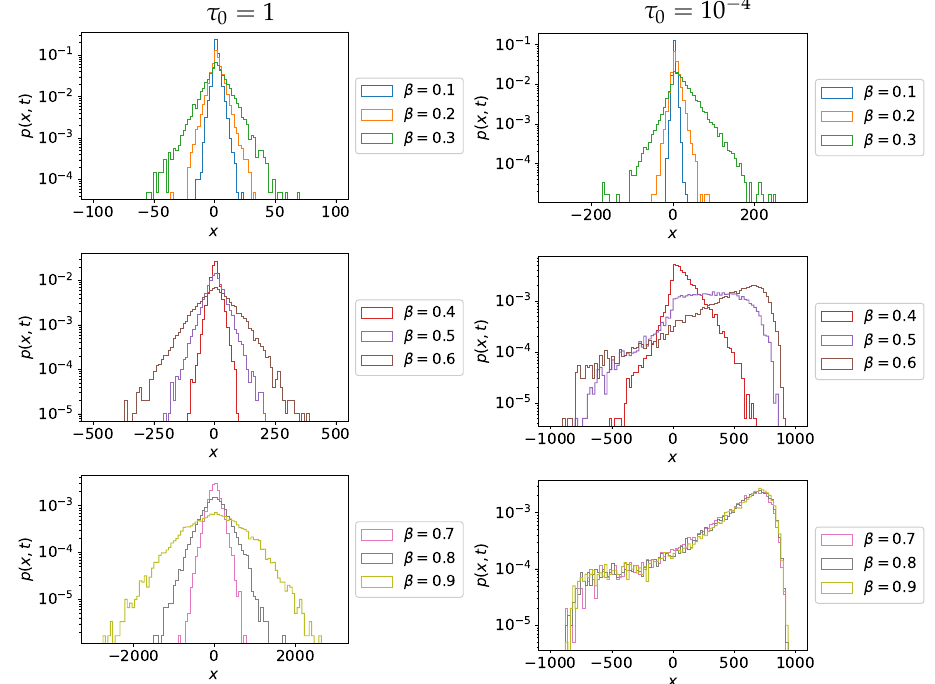
Figure 5. Plot of PDFs for Monte Carlo simulated trajectories at t = 10 6 (left column) and t = 10 3 (right column). Each value of β has N = 10 4 trajectories. The parameters used were α 0 = 0.6, ν = 1, λ = 1 and τ 0 = 1 (left column) or τ 0 = 10 − 4 (right